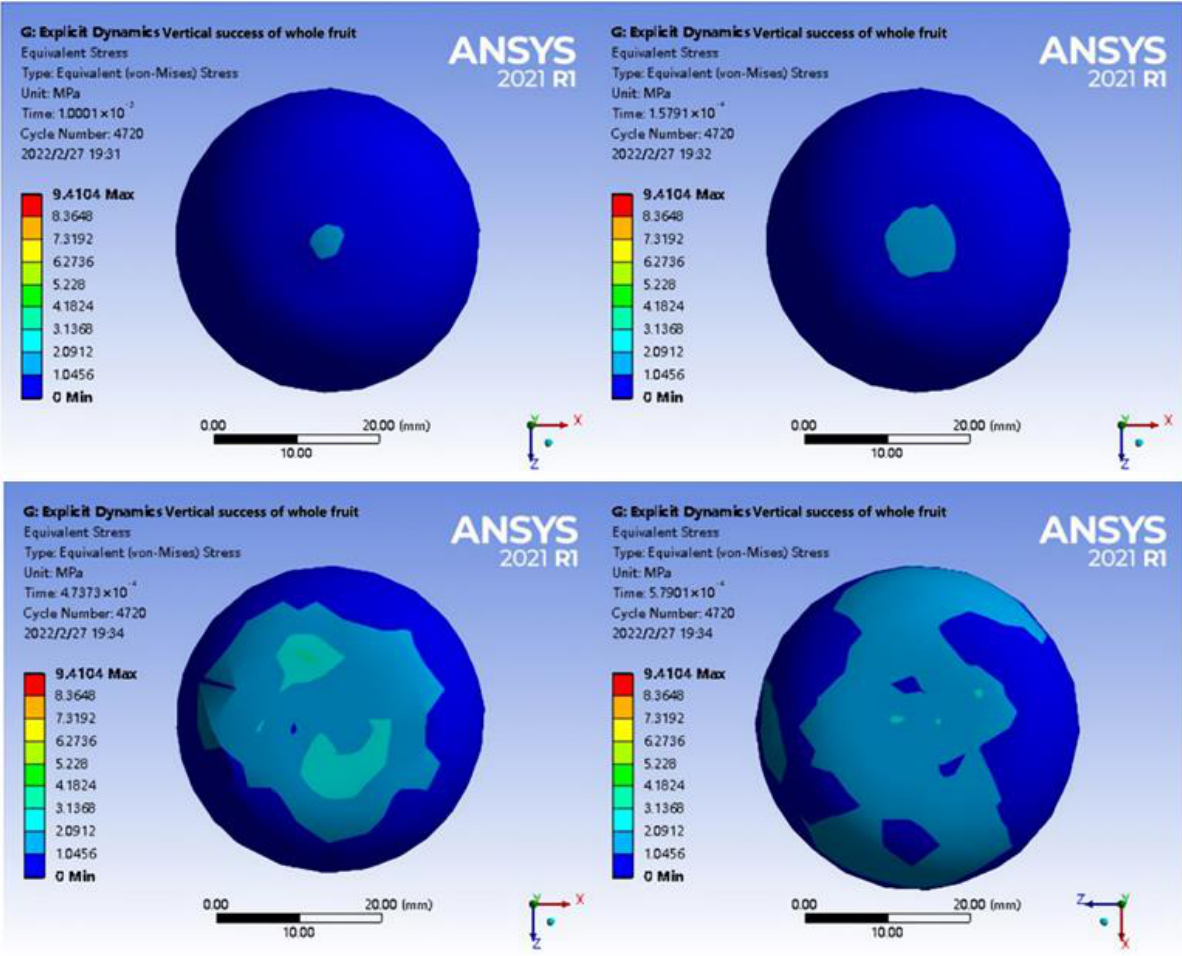
Figure 10. Stress change diagram of intact fruit under axial loading.